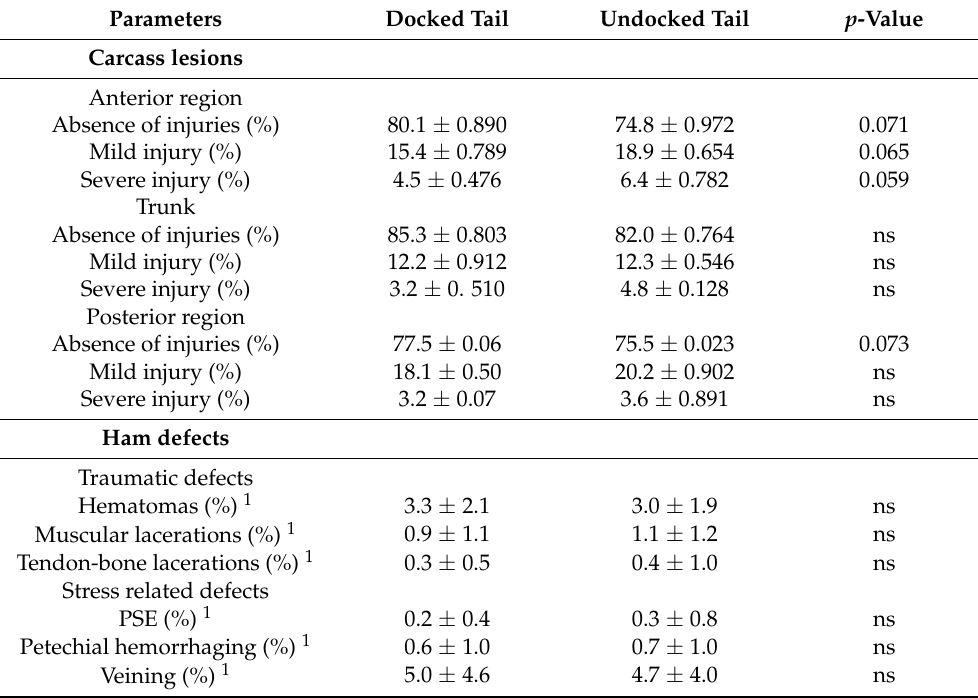
Table 4. Average percentage of lesions ( ± standard error*) observed in different parts of the carcass (anterior, trunk, posterior) and ham defects in relation to tail docking. Only p -values lower than 0.090 are